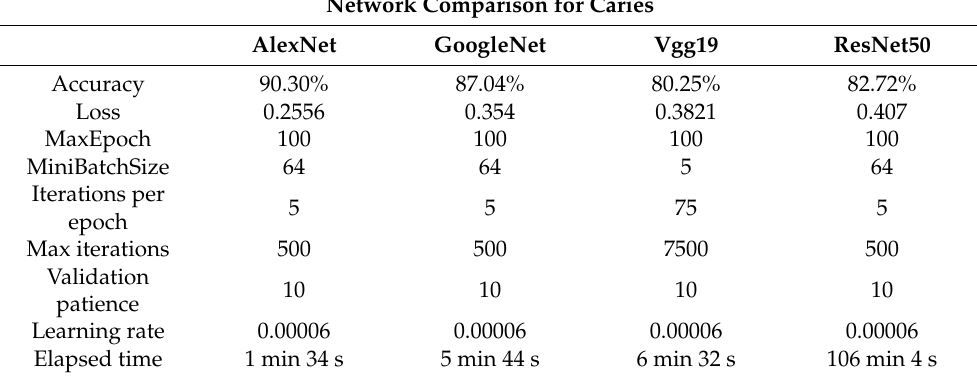
Table 10. Network comparison for caries.